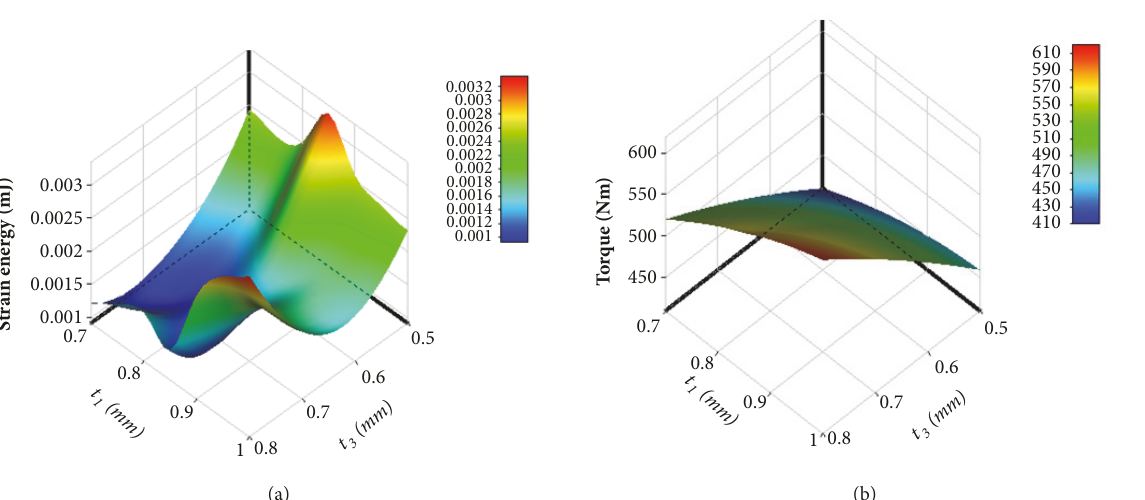
Figure 12: Effect diagram of t